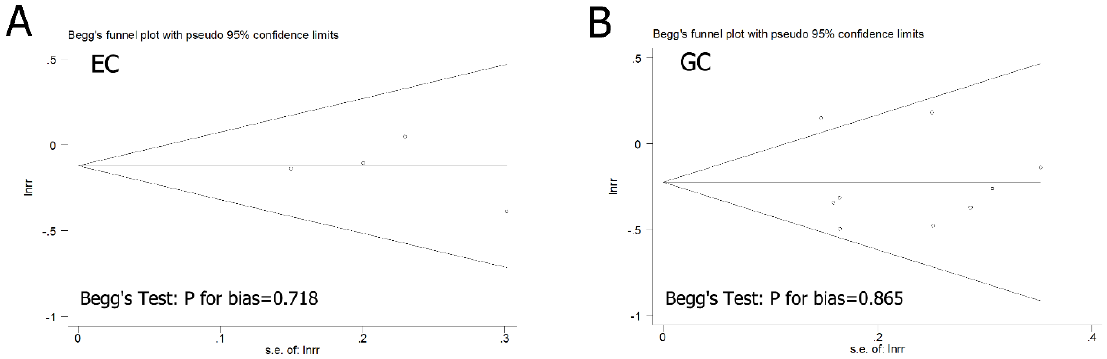
Figure 3. Funnel plot of flavonol intake and the risk of esophageal and gastric cancer.